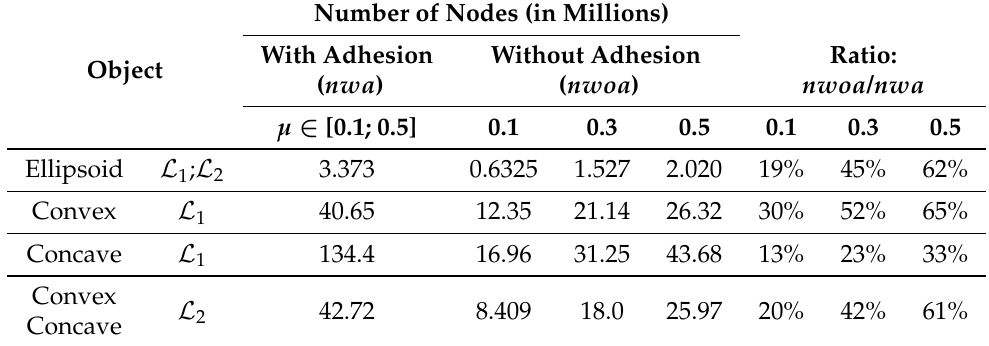
Table 2. Impact of friction coefficient ( µ : 0.1–0.5) on the number of admissible stable grasps (no. of